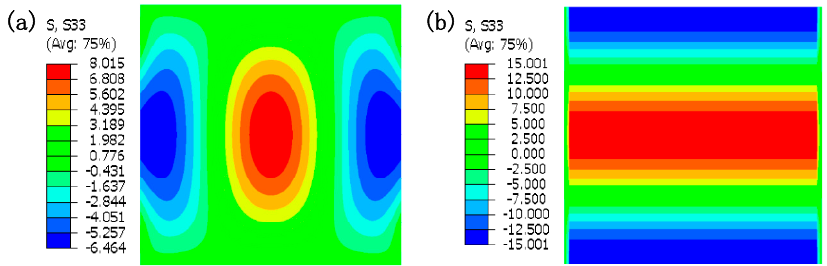
Figure 5. Longitudinal stress at a stable time calculated by different methods under a medium aspect ratio of 1:1: ( a ) FEM; and ( b ) FE-IE coupling method.